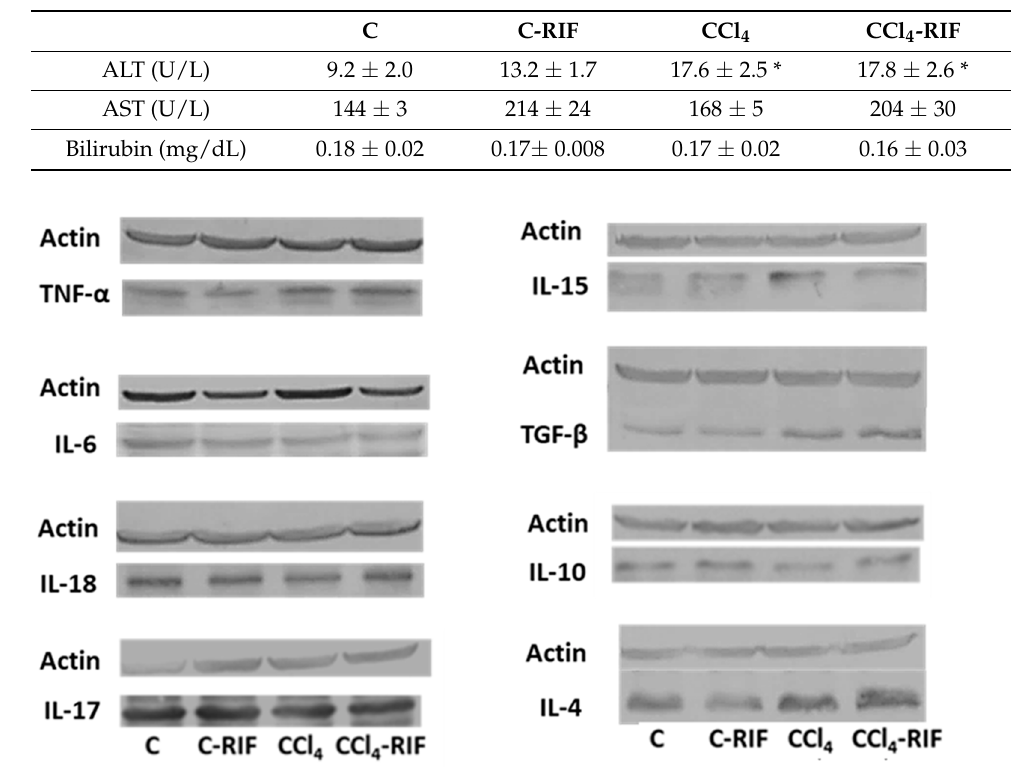
Figure 3. Representative bands from western blots of liver cytokines corresponding to data described in Table 1.